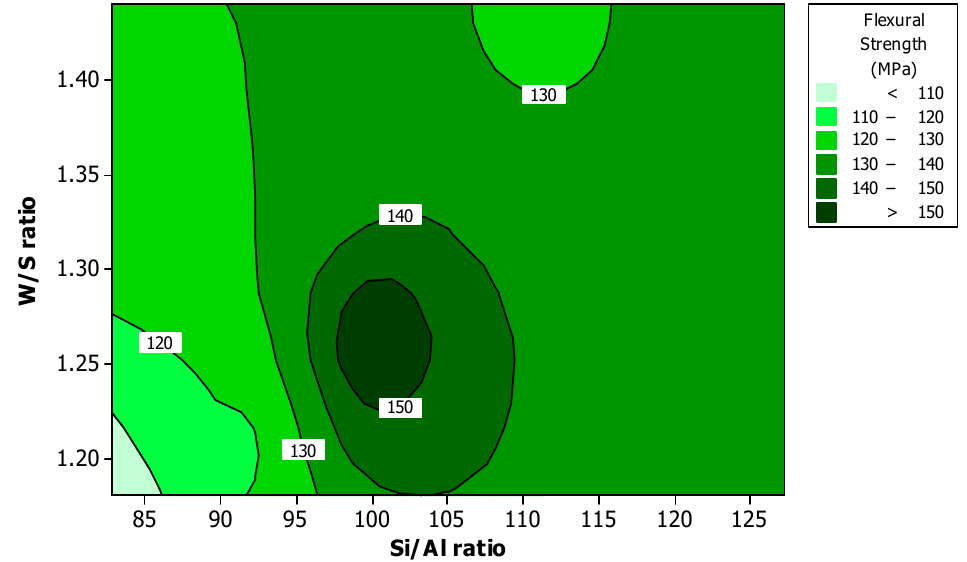
Figure 4. Contour plot of W/S ratio vs. Si/Al ratio for flexural strength.